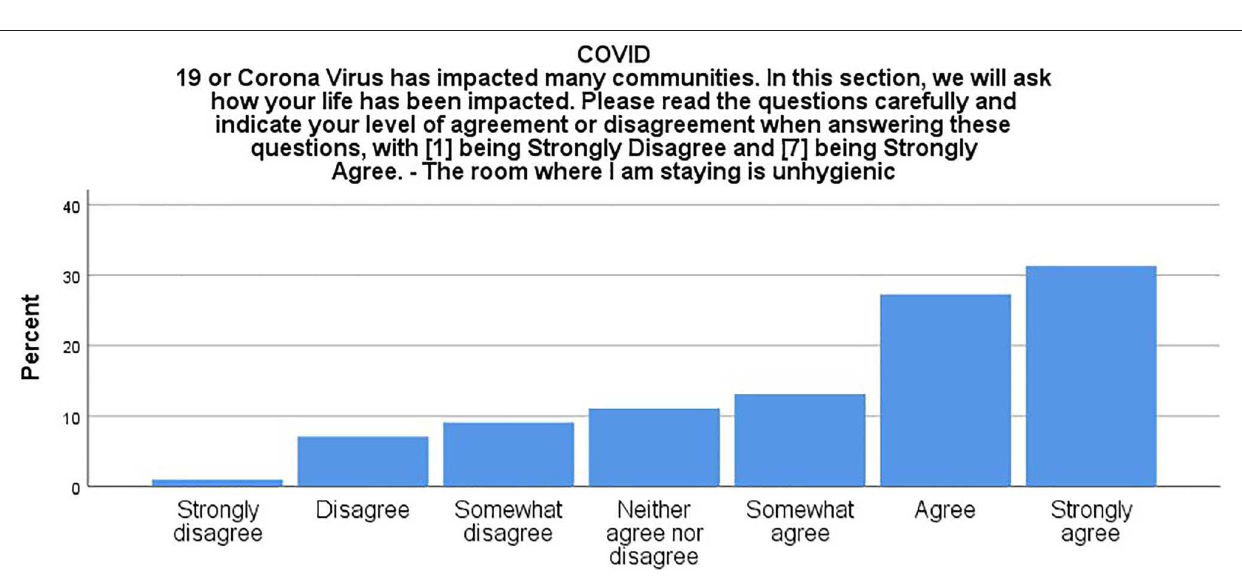
FIGURE 3 | Distribution of participants reporting their rooms as